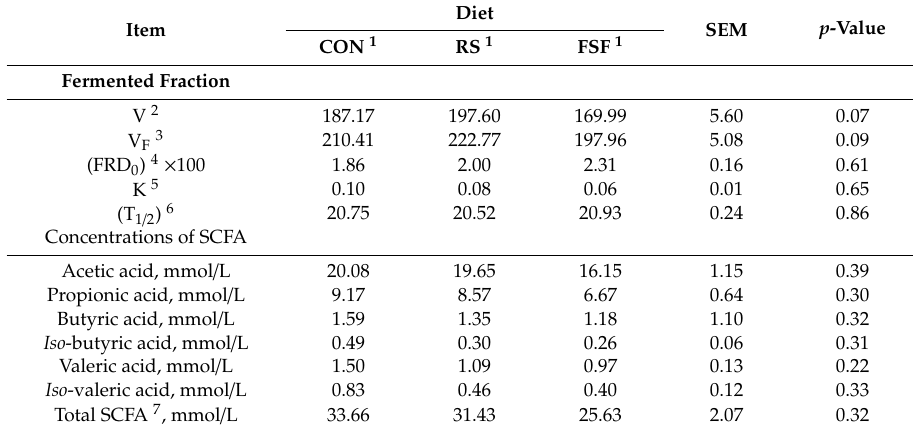
Table 2. Gas production parameters and concentrations of short-chain fatty acids (SCFA) during the in vitro fermentation of enzymatically hydrolyzed residues of the three diets using fecal inocula from gestation